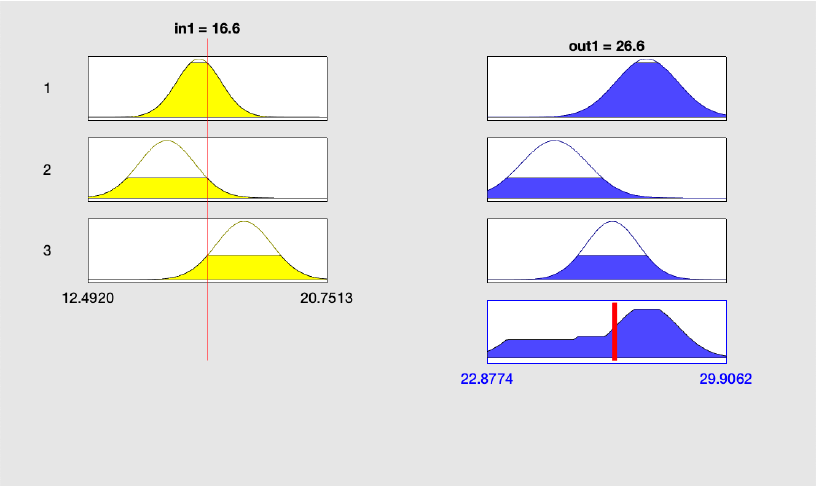
Figure 21. Graph of Fuzzy rule set.